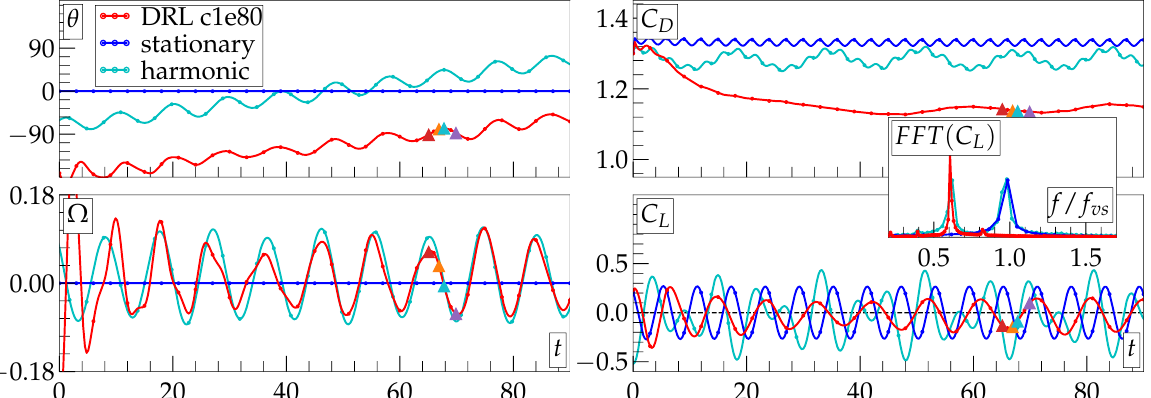
Figure 7. Rotation angle and angular velocity ( Left ); and the drag and lift coefficients ( Right ). Three flow regimes are shown: the stationary cylinder (blue line), with a DRL-scheme corresponding to c1e80 for control (red line) and forced with harmonic-based oscillations with Ω ( t ) = Ω 0 [ sin ( 2 π f 1 t + ϕ 1 ) + 0.15 ][ 1 + 0.1sin ( 2 π f 2 t + ϕ 2 )] where Ω 0 = 0.09, f 1 = 0.61 f vs , f 2 = 0.22 f vs (green line). See also the Supplementary Material Video S1 (also available at: https://youtu.be/9X8XtHk0R84). Several triangle points